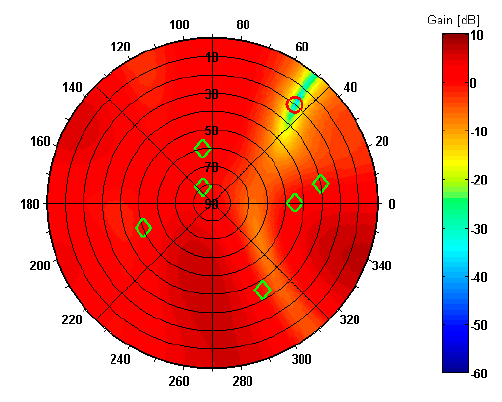
Figure 8. Reception pattern of antenna array in spoofing scenario 1.